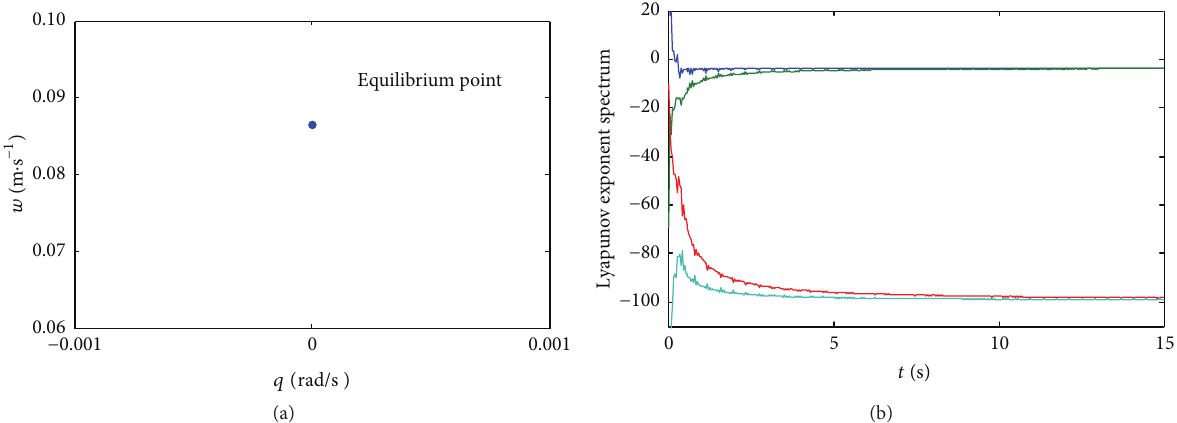
Figure 7: (a) Phase trajectory diagram in 𝑤 − 𝜃 plane and (b) Lyapunov exponent